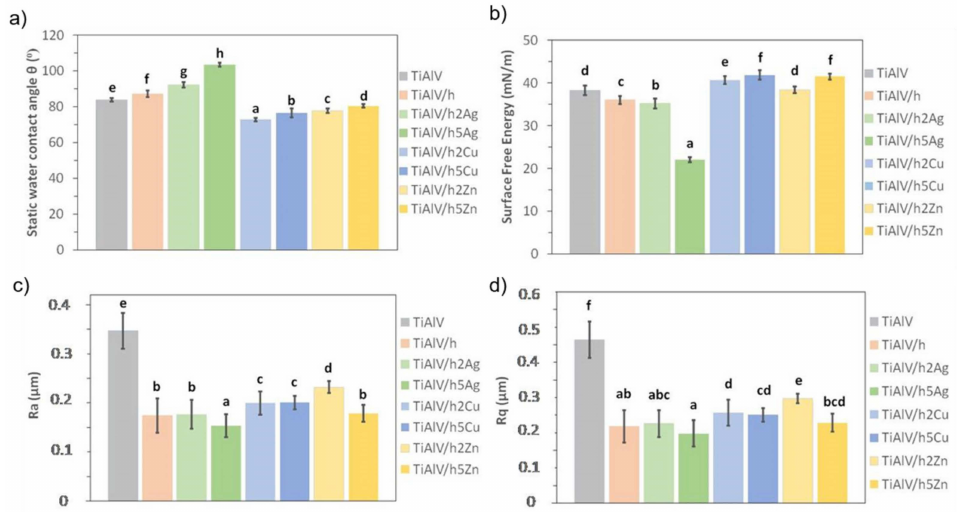
Figure 7. Static water contact angle ( a ), surface free energy ( b ), and roughness parameters ( c , d ) of titanium alloy (TiAlV)-covered sol–gel hybrid layer containing silver, copper, and zinc nanoparti- cles. Statistically significant differences ( p < 0.05) in the studied parameters between the different coating types are indicated by different lower-case letters. Bars marked with the same letters are not statistically